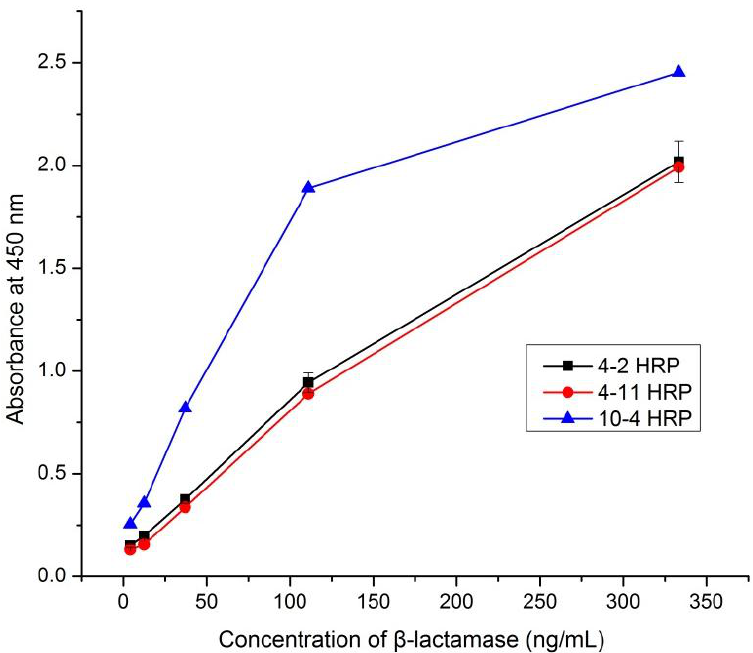
Figure 1. Comparison of running curves between different